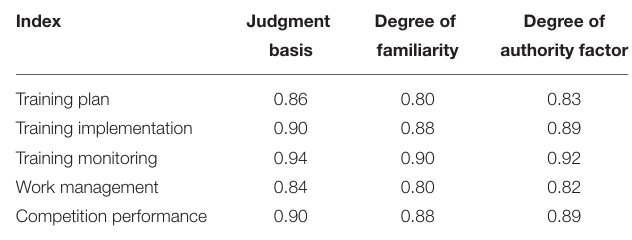
TABLE 4 | Statistical table of expert authority coefficient.